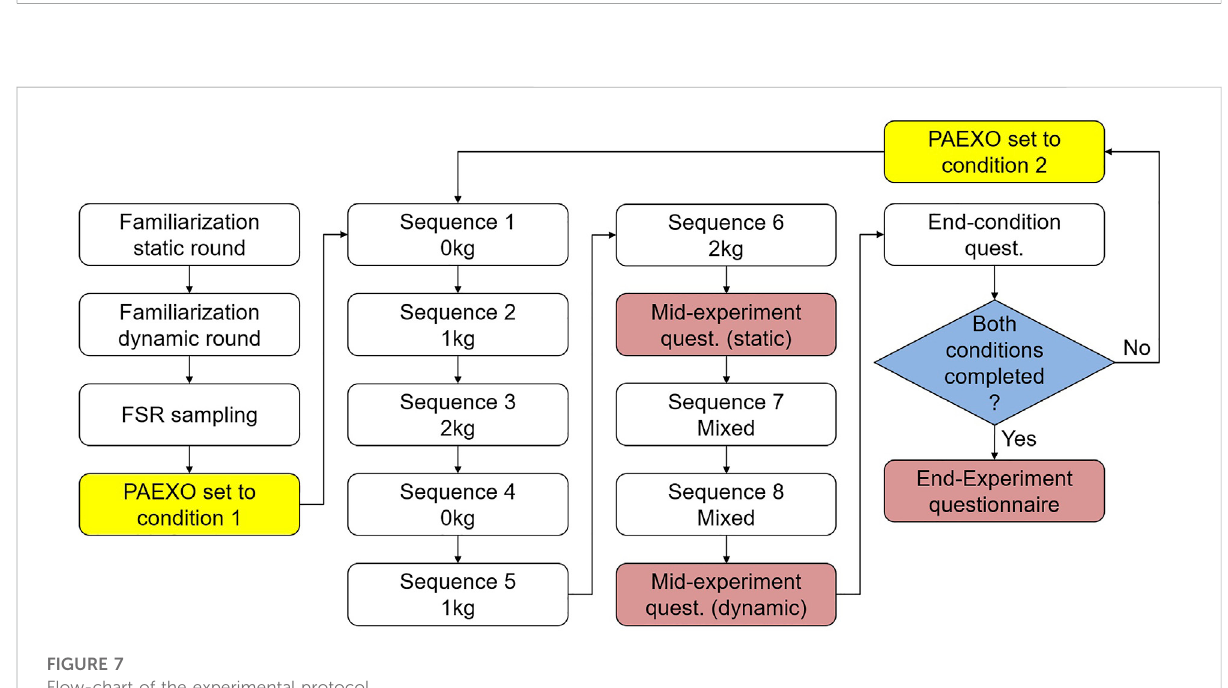
FIGURE 7 Flow-chart of the experimental